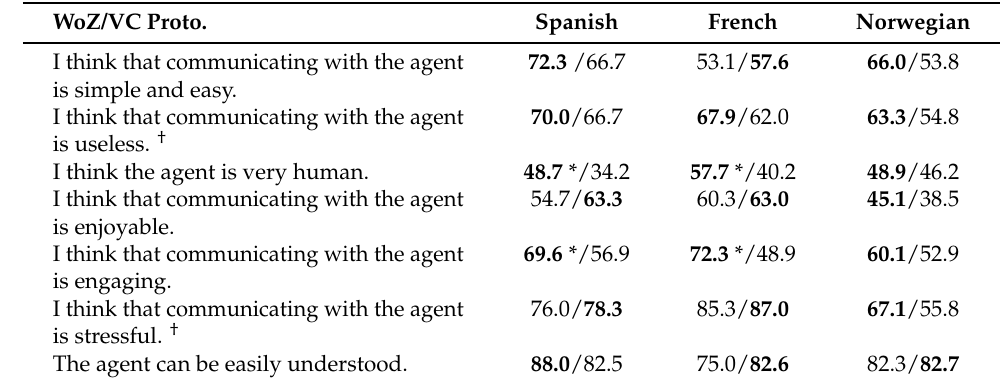
Table 13. Scores of seven VAAQ questions for WoZ experiments, and for the VC prototype. Values in bold indicate the best result for each comparison, and the mark * shows if the difference is statistically